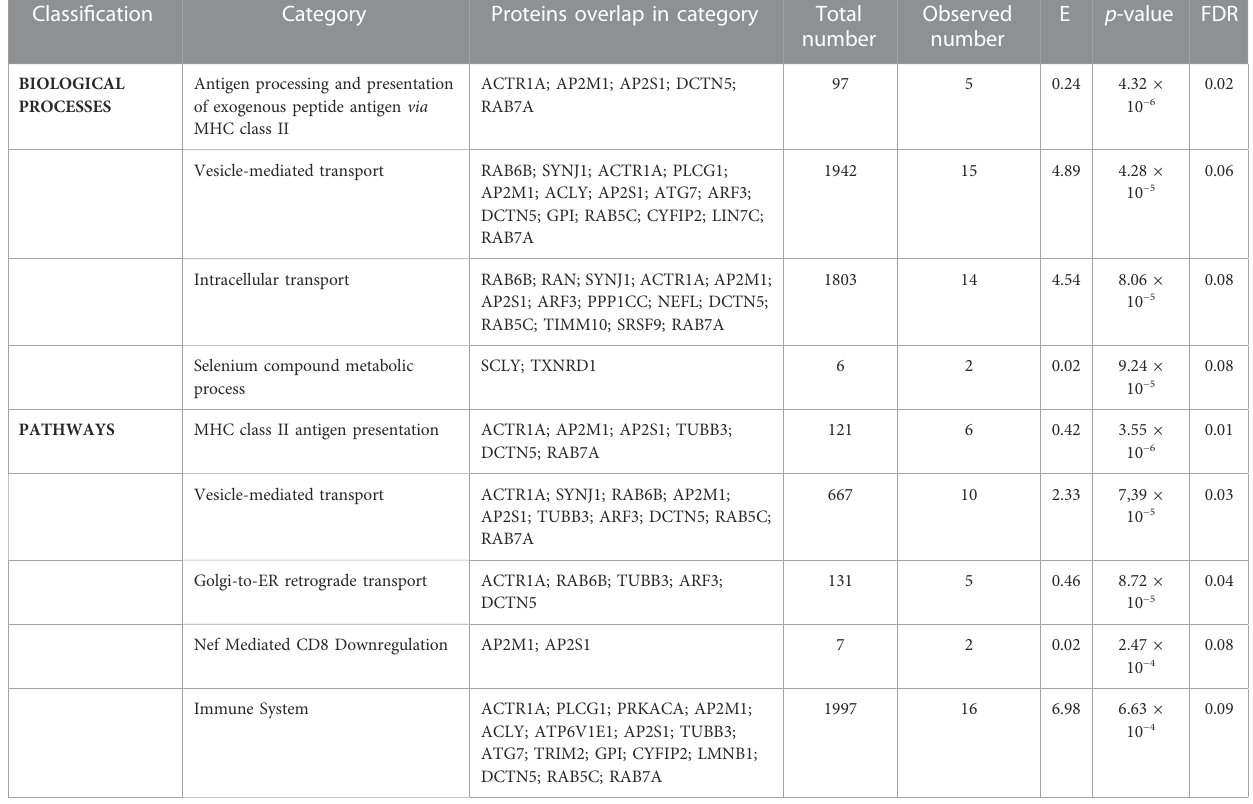
TABLE 2 Non-redundant gene ontology analysis of the 43 proteins altered in the dorsolateral prefrontal cortex. Classi fi